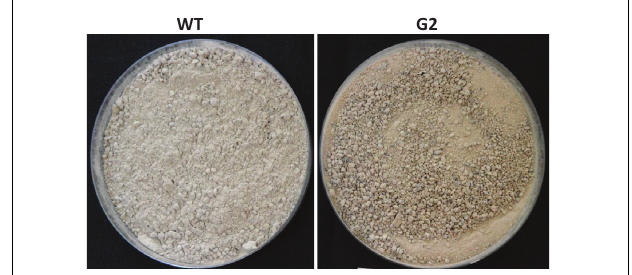
FIGURE 6 | Genes upregulated in T. virens mutant G2, over wild type, when grown on PDA for 3 days. Hypo: hypothetical/unknown proteins; SSCP: small, cysteine-rich secreted proteins; OXIDO: oxidoreductases; GH: glycosyl hydrolases; SEC. META.: gene predicted to be involved in secondary metabolism (includes PKS, P450, NRPS-like, OMT-B, and MFS transporters); HYD: hydrophobins; PEP: peptidases.